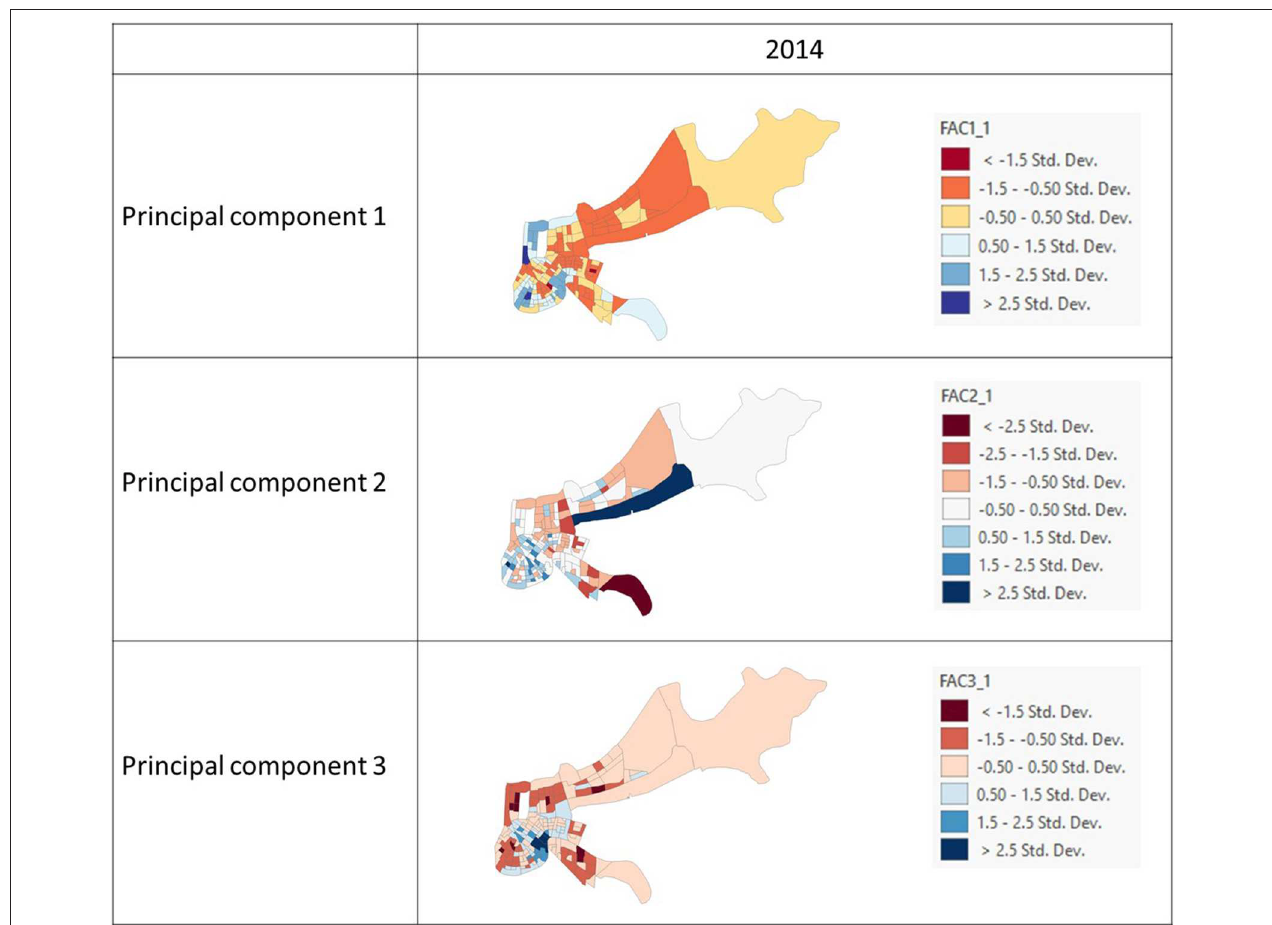
FIGURE 7 | First three principal components for 2014. Classified by standard